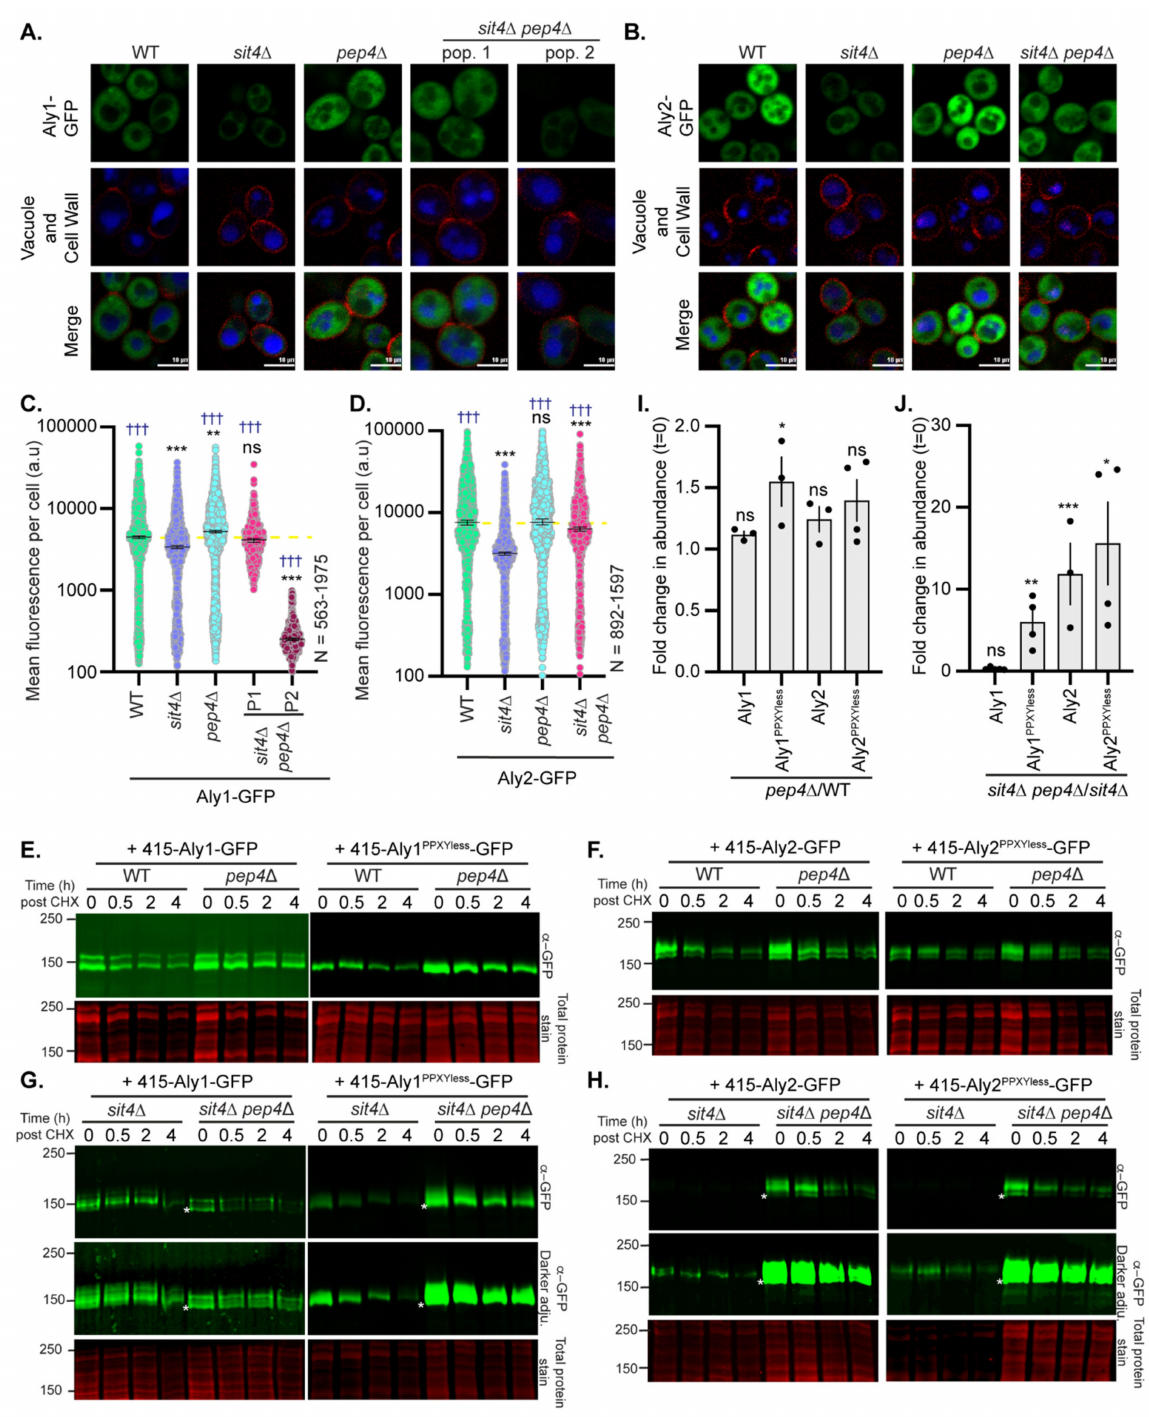
Figure 9. Impaired vacuole protease function increases Aly protein abundance: ( A ) Aly1-GFP or ( B ) Aly2-GFP was expressed from the TEF1pr in either WT cells or those lacking the gene indicated and imaged by high-content fluorescence microscopy. CMAC is used to stain the vacuoles (shown in blue), and trypan blue (shown in red) is used to mark the cell wall. ( C ) or ( D ) The whole-cell fluorescence of cells imaged in ( A ) or ( B ), respectively, was determined using NIS. ai software, and the fluorescence for each cell is plotted as a circle. The median fluorescence intensity is shown as a black line for each group, and the error bars represent the 95% confidence interval. A yellow dashed line represents the median fluorescence intensity for Aly1 or Aly2, expressed in WT cells in panels ( G ) and ( H ), respectively. Kruskal–Wallis statistical analysis with Dunn’s post hoc test was performed